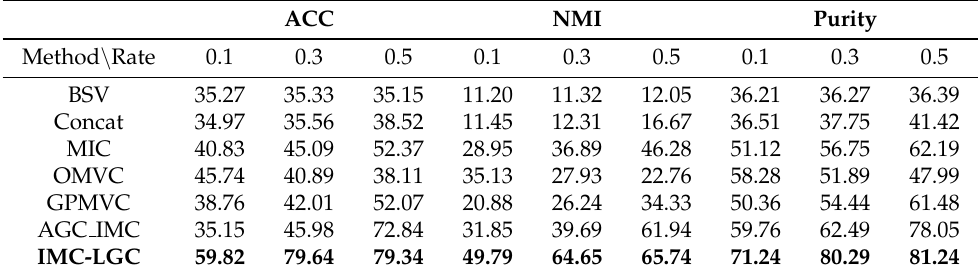
Table 2. Average values of ACC (%), NMI (%), and purity (%) of different methods in 3 source datasets with different observed rates of paired samples. Bold numbers denote the best results. ACC NMI Purity